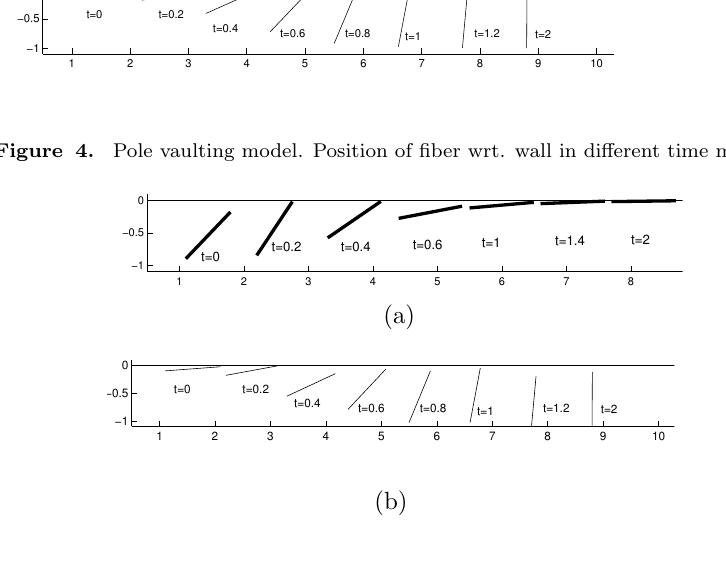
Figure 5. Fiber drifting (˙ h < 0) towards the wall ( y = 0) and remaining in contact (a) and recoiling from the wall (b). 3. Combination of sliding and pole vaulting (both p and h are influenced, fiber remains in contact with wall after collision, see Fig. 5a); 4. Recoiling (fiber loses contact with wall right after collision, see Fig.